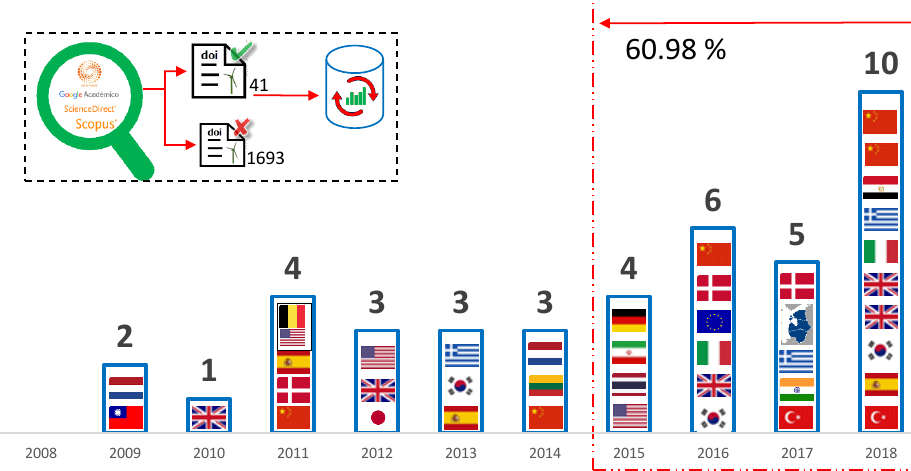
Figure 5. Offshore wind power plant optimal location. Frequency of publications